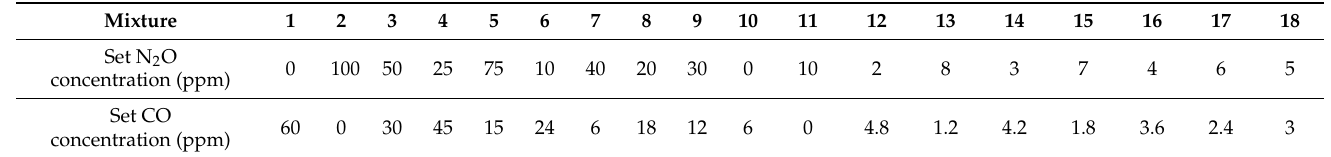
Table 2. Setpoints for measured mixtures of N 2 O and